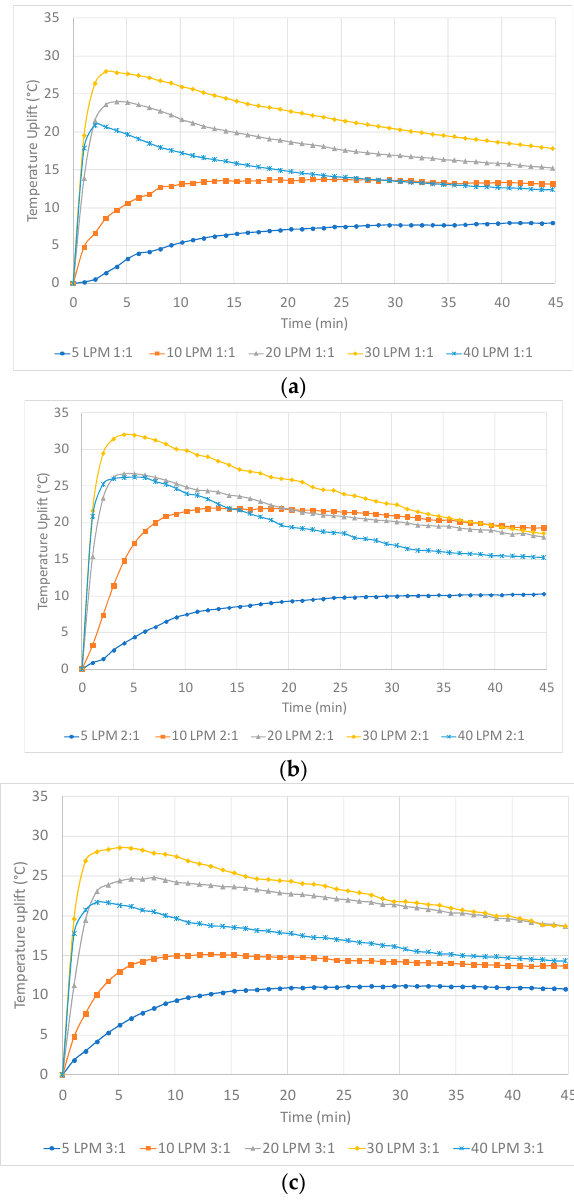
Figure 4. Thermal response of ( a ) 1:1 SIM, ( b ) 2:1 Sim and ( c ) 3:1 SIM under varying flow rate conditions in Reactor 1 at an inlet conditions of 17 g H 2 O/m 3 and 20 °C.